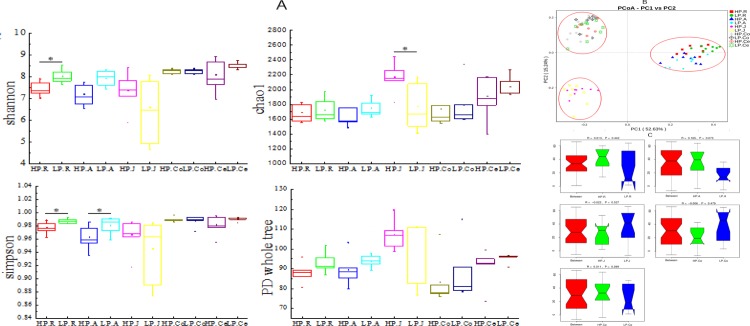
A: Comparison of alpha diversity indices between the HP and LP groups. Error bars represent the SD of two samples. Asterisks show significant differences between groups (*P<0.05), the same as below. B: Principal coordinate analysis of bacterial samples from the gastrointestinal tract. A greater distance between two samples indicated a lower similarity. The percentage of variation explained by PC1 and PC2 are indicated on the axis. C: A microbial analysis of similarities (ANOSIM). R was the mean rank of between-group dissimilarities, ranging from -1 to 1. When the R value is greater than 0, the difference between groups is greater than that within groups, indicating that there are differences between groups; when the P value is less than 0.05, it indicates significant differences between groups. HP.R: rumen of HP; LP.R: rumen of LP; HP.A: abomasum of HP; LP.A: abomasum of LP; HP.J: jejunum of HP; LP.J: jejunum of LP; HP.Co: colon of HP; LP.Co: colon of LP; HP.Ce: cecum of HP; LP.Ce: cecum of LP.